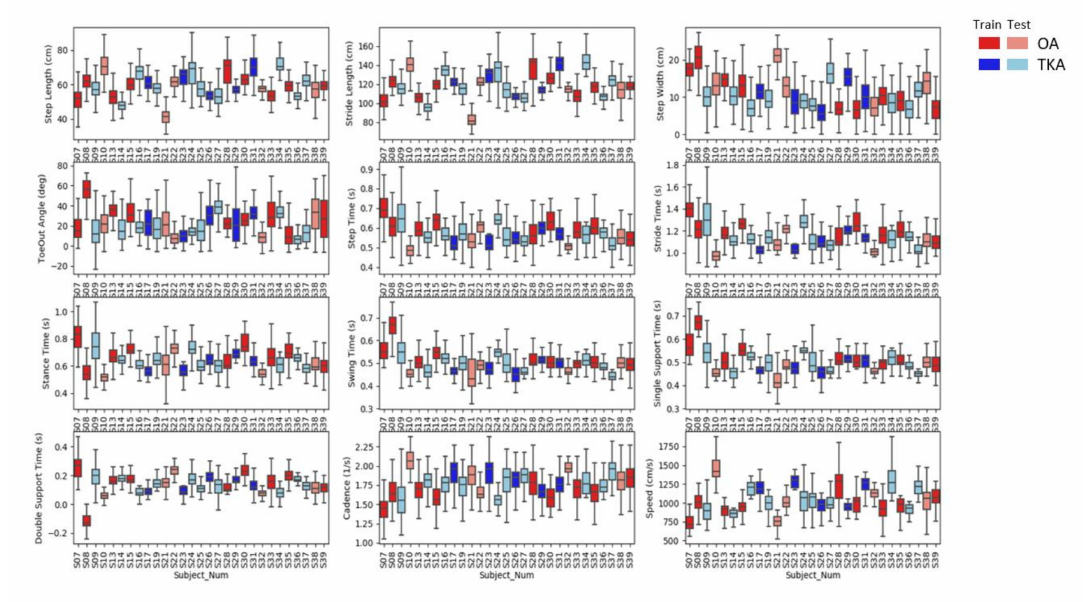
Figure A1. Boxplot associated with spatiotemporal gait parameters (STGPs) of each subject grouped by their knee status (OA and TKA) for training and test set.